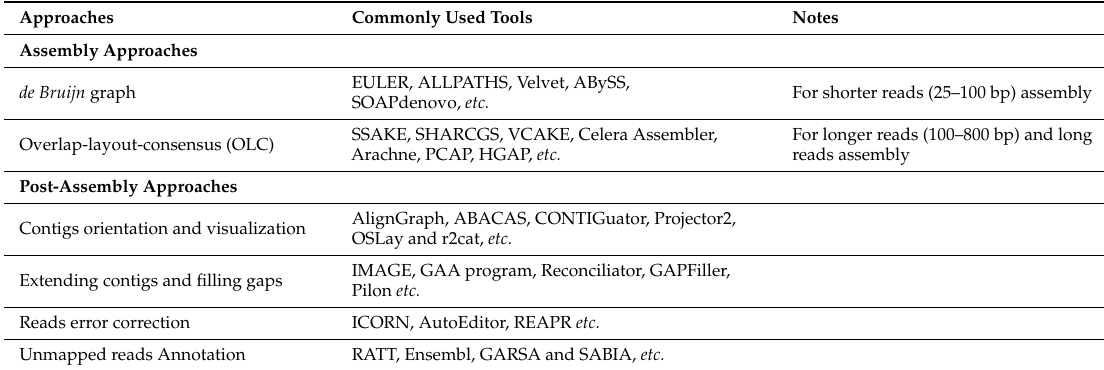
Table 3. Genome de novo assembly and post-assembly approaches.